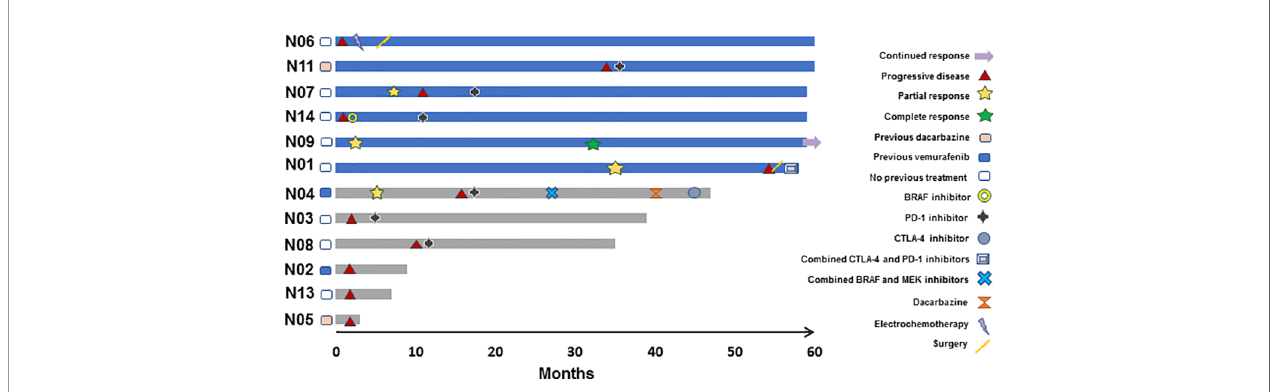
FIGURE 2 | Ef fi cacy assessment by subject censored on December 1 2020. Swimmers plot depicting individual patients as lines, illustrating duration of overall survival in months. Blue and grey colors indicate alive and deceased patients, respectively ( N =12). Responses and new systemic treatment are indicated by designated symbols. Patient N06 received locoregional chemotherapy and surgery, but no further